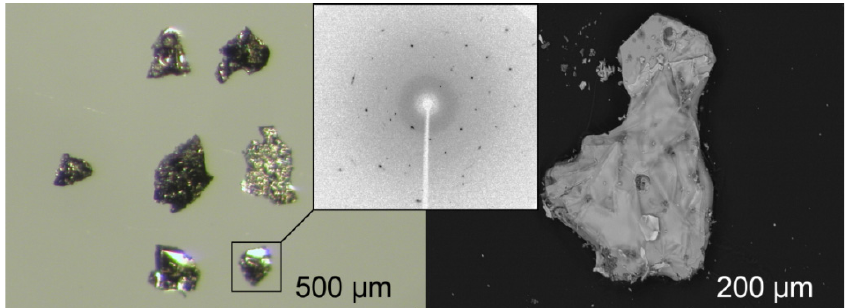
Figure 1. Crystal aggregates of Ca microscope ( right ). The inset shows a Laue-image of a representative single